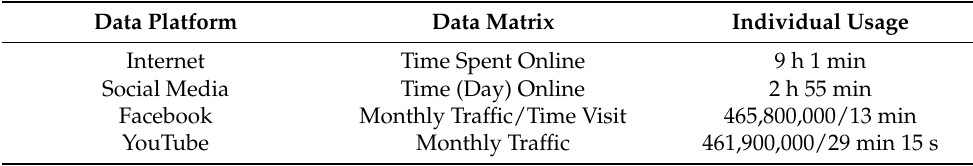
Table 2. Thai Social Media